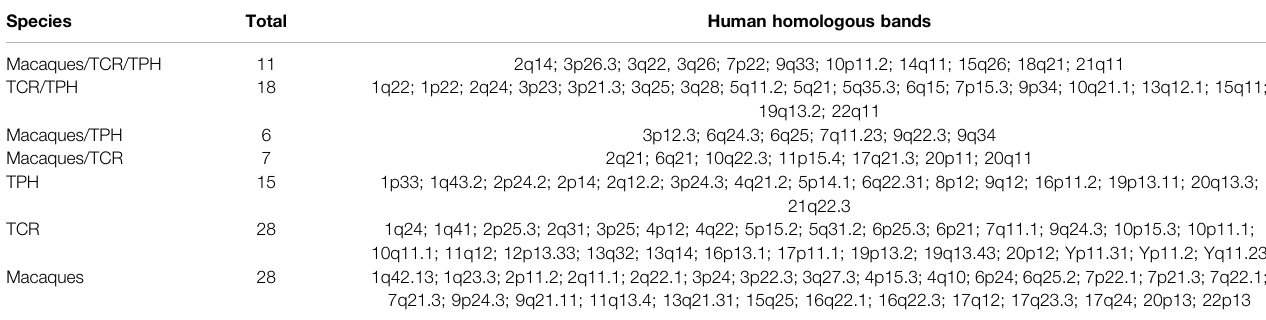
TABLE 3 | ECBs in TPH, TCR, and macaque species given as corresponding homologous human chromosome bands.